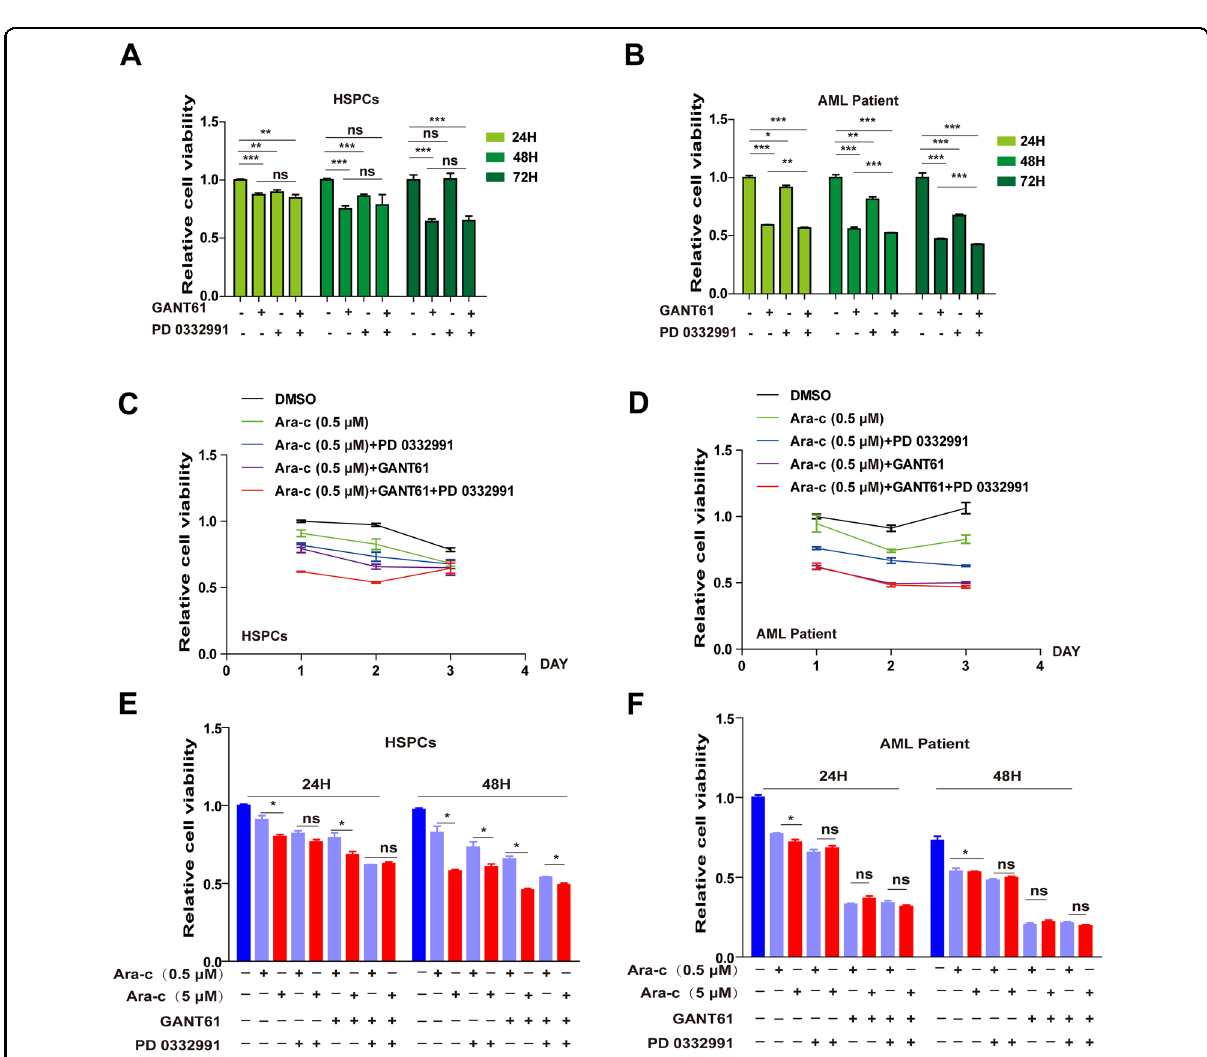
Fig. 6 Co-treatment with GLI1 and CDK4/6 inhibitors enhanced the cytarabine sensitivity of AML patients. A , B Cell viability of HSPCs ( A , n = 3) and AML patients ( B , n = 3) treated with GANT61 and PD 0332991. C , D HSPCs ( C , n = 3) and AML patients ( D , n = 3) were treated with Ara-c (0.5 μ M) and/or GANT61 (20 μ M) /PD 0332991 (0.5 μ M) or Ara-c (0.5 μ M), GANT61 (20 μ M) and PD 0332991 (0.5 μ M). E , F HSPCs and AML patients ( F ) were treated with Ara-c (0.5 μ M or 5 μ M) and GANT61/PD 0332991 or Ara-c + GANT61 + PD 0332991 for 24 h and 48 h. Cell viability was determined by CCK8. P values were obtained by a two-tailed Student ’ s t -test and two-way ANOVA. * P < 0.05, ** P < 0.01, *** P < 0.001, ns not signi fi